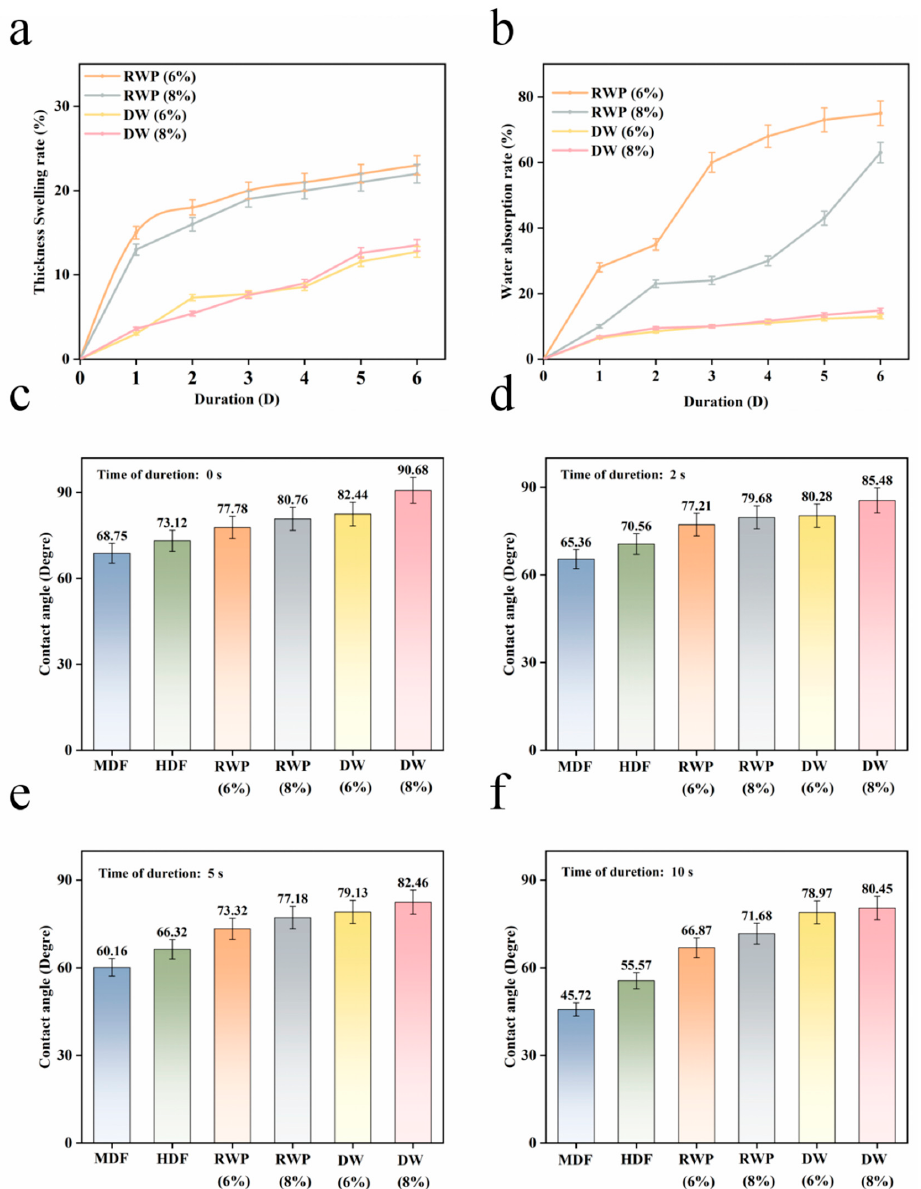
Figure 3. ( a ) Comparison of water-absorption thickness-swelling rate; ( b ) Comparison of water absorption rate; ( c – f ) Comparison of contact angle (0 s, 2 s, 5 s, 10